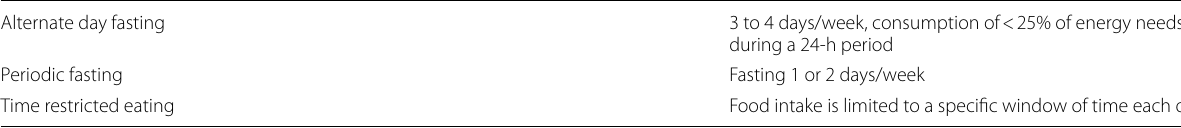
Table 5 Types of fasting